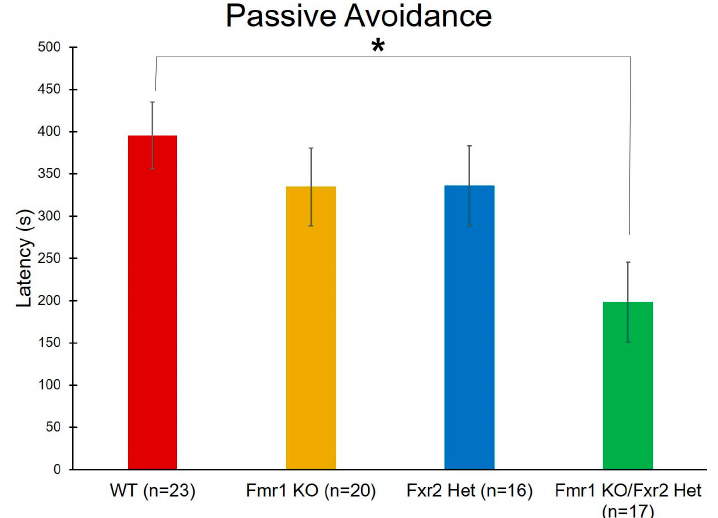
Figure 7. To assay learning and memory, we performed the passive avoidance test. We found a statistically significant effect of genotype on latency to enter the dark chamber ( p = 0.022). Post-hoc tests revealed that Fmr1 KO/ Fxr2 Het mice had statistically significantly shorter latencies to enter the dark than WT mice ( p = 0.014), indicating a deficit in memory. Each bar represents the mean ± SEM for the number of mice indicated on the figure. *, p < 0.05.